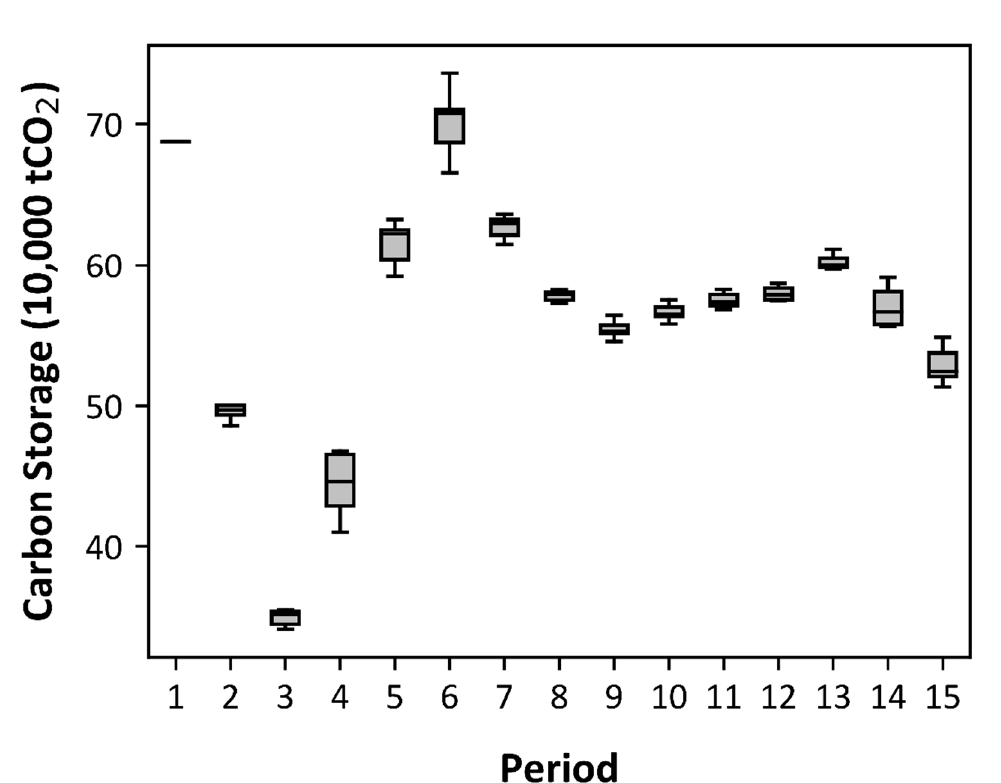
Figure 8. Distribution of carbon storage by alternatives in each period. The data in each boxplot include 9 points, representing the carbon storage volume in the period for each alternative.